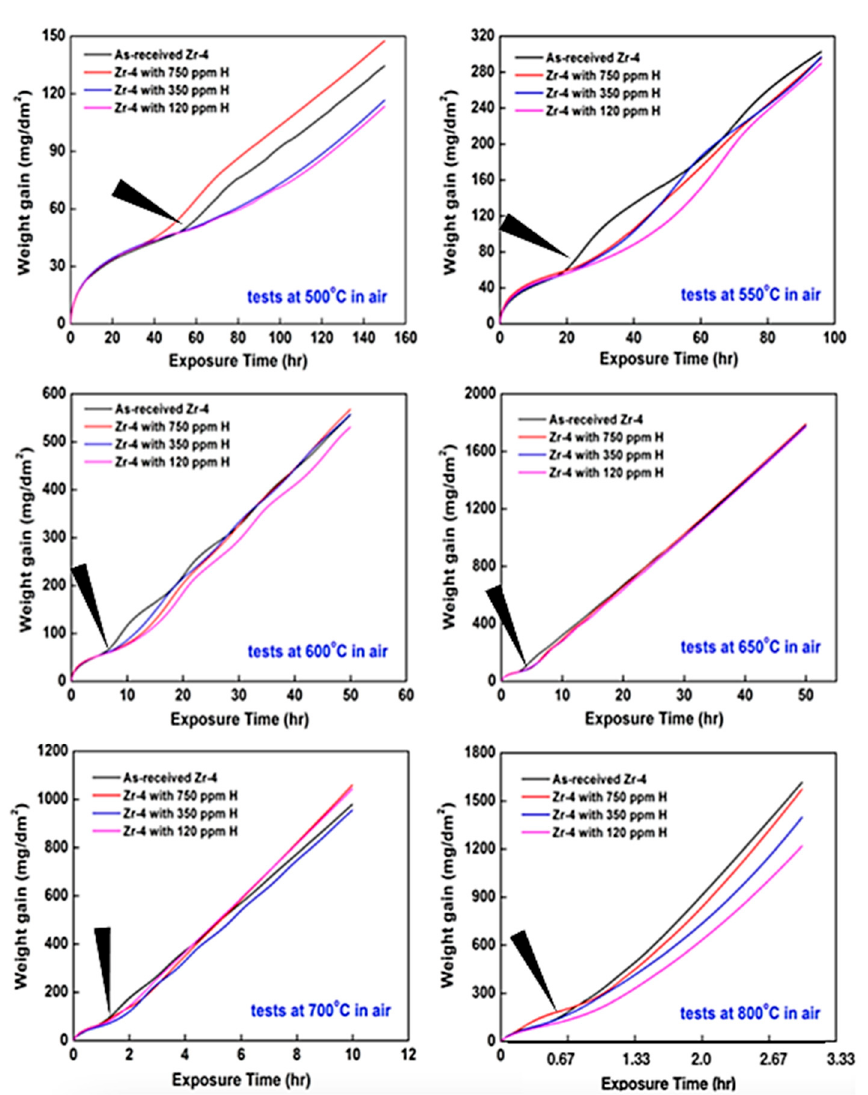
Figure 3. TGA results for the isothermal oxidation of the as-received and hydrided Zircaloy-4 cladding specimens in the temperature range of 500–800 °C (plot of weight gain per surface area vs. time).